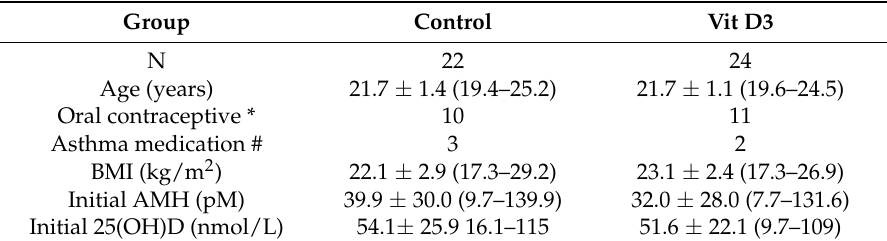
Table 1. Participant